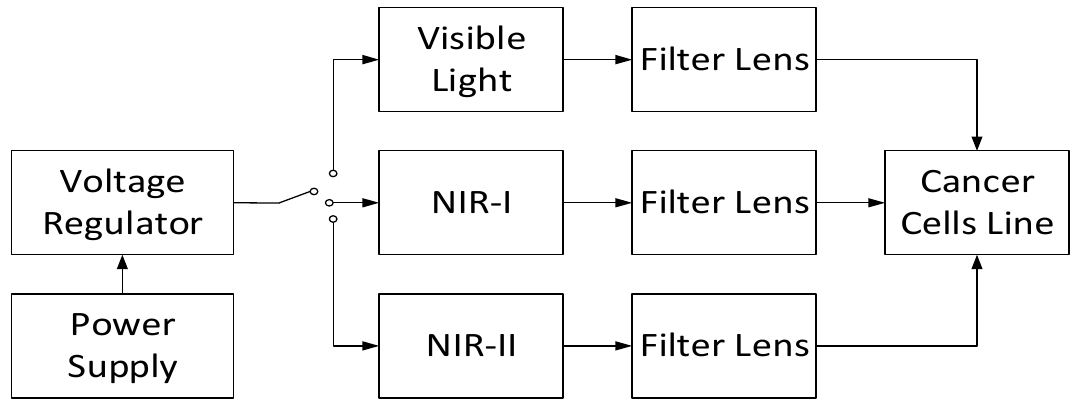
Figure 5. Combined NIR-I and NIR-II with visible light instrumentation. Moreover, an in vitro system can be developed by applying the combinations of NIR-I, NIR-II, and other cancer-suppressor modalities, such as ultrasound, as shown in Figure 6. When other modalities are implemented, a signal conditioner circuit (SCC) is required to generate the ideal signal for such modalities. This SCC can be a function generator, power amplifier, clipper-clamper circuit, ripple reduction circuit, and others. With these combinations, the cancer cells may be eradicated successfully compared to the control